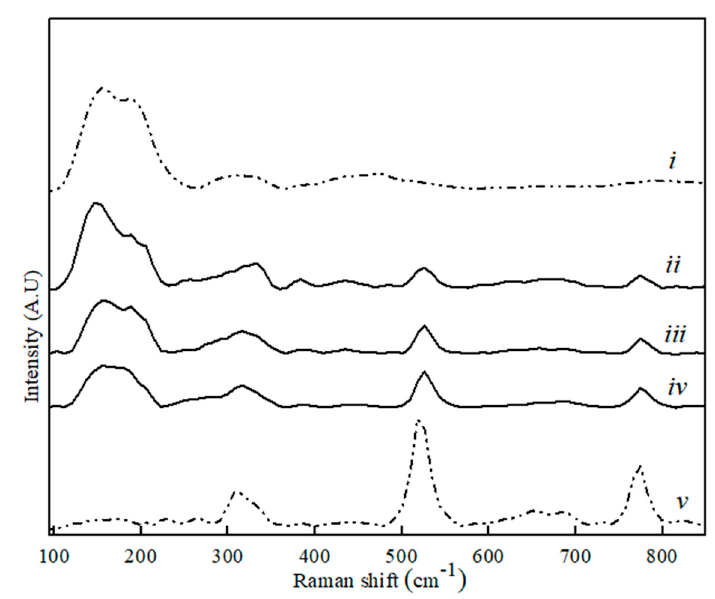
Figure 6. Raman spectra for CaS ( i ), C12A7 ( v ) and binary CaS–C12A7 phase sample with CaS content, where ( ii ) 80 wt. %, ( iii ) 60 wt. %, and ( iv ) 20 wt. %.